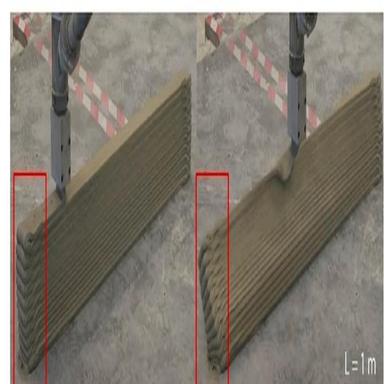
(a) Printing failure induced by the increase of nozzle standoff distance, adapted from Ref.; (b) The excess material deposited on both sides of each filament, adapted from Ref..